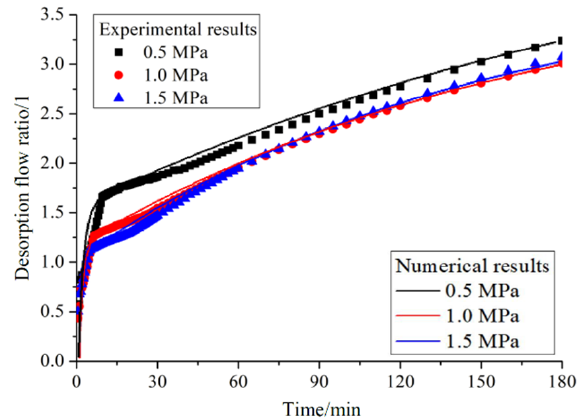
Figure 5. Experimental results of methane desorption flow for Guhanshan coal.